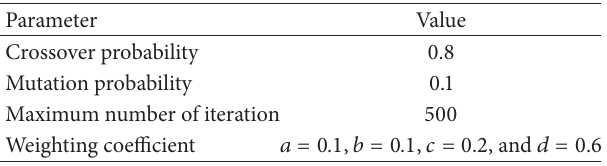
Table 6: Experiment parameter value.